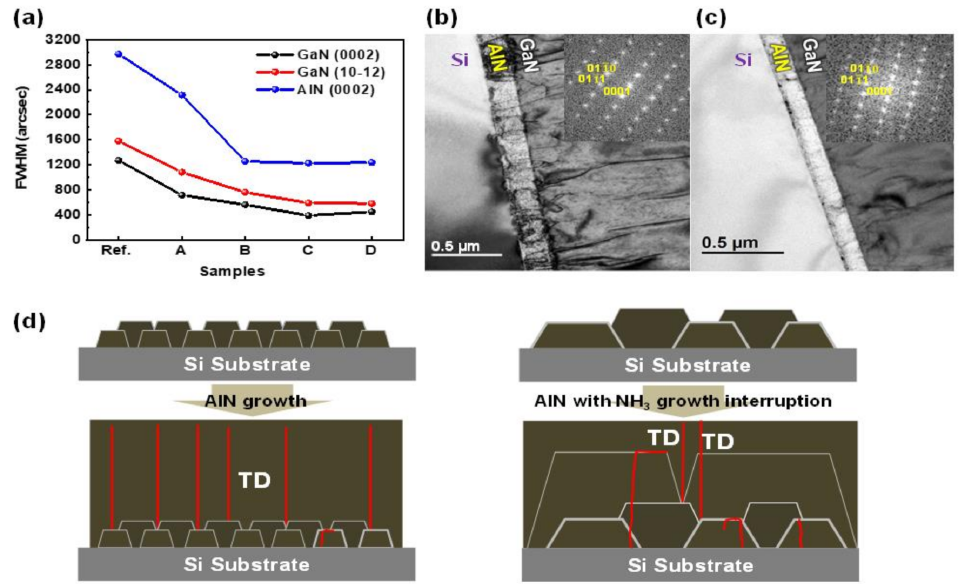
Figure 3. ( a ) The full-width-at-half-maximum (FWHM) values of the GaN (0002), GaN (10–12), and AlN (0002) reflections for all the samples. TEM images of ( b ) a reference sample and ( c ) a sample C. ( d ) Schematic growth mechanism of AlN with and without the NH 3 growth interruption.